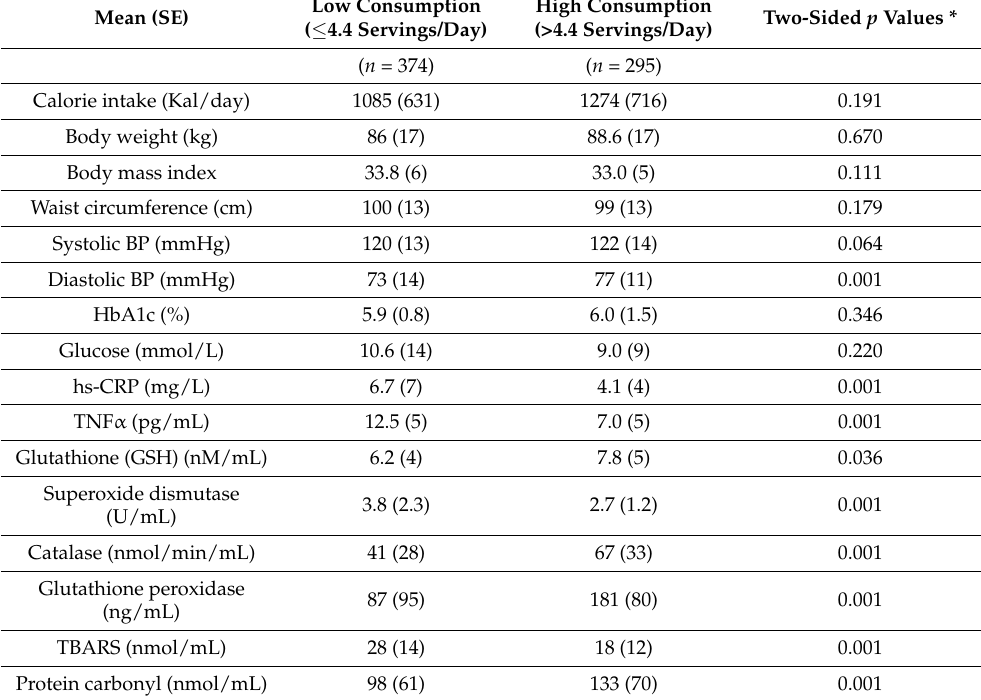
Table 4. Baseline anthropometrics, BP, lipid and antioxidant contents, and markers of oxidative dam- age and inflammation in those with a high fruit and vegetable consumption vs. a low consumption.